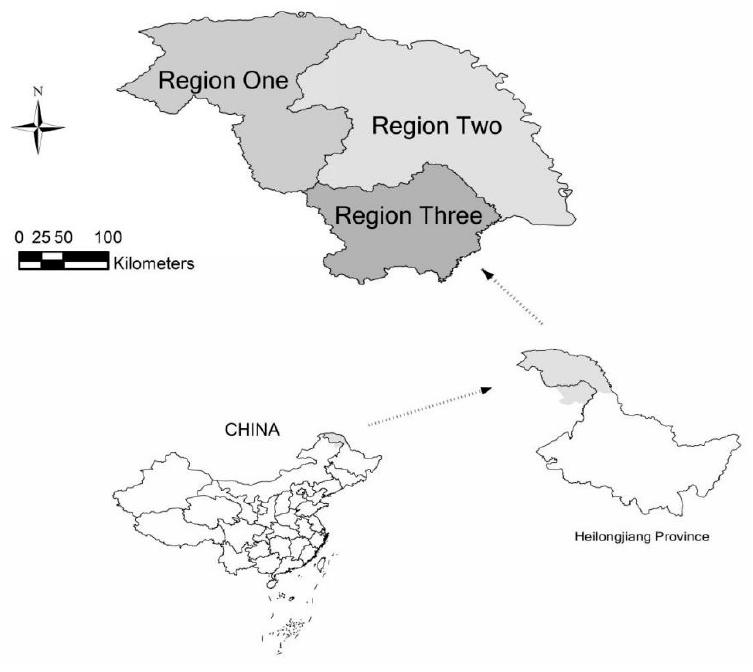
Figure 1. Study Area. Table 1. Descriptive statistics for Dahurian larch sample trees in Daxing’anling. Group